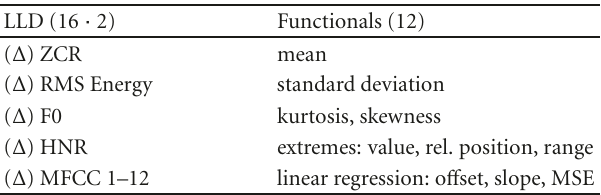
Table 2: INTERSPEECH 2009 Emotion Challenge feature set (IS): low-level descriptors (LLD) and functionals.